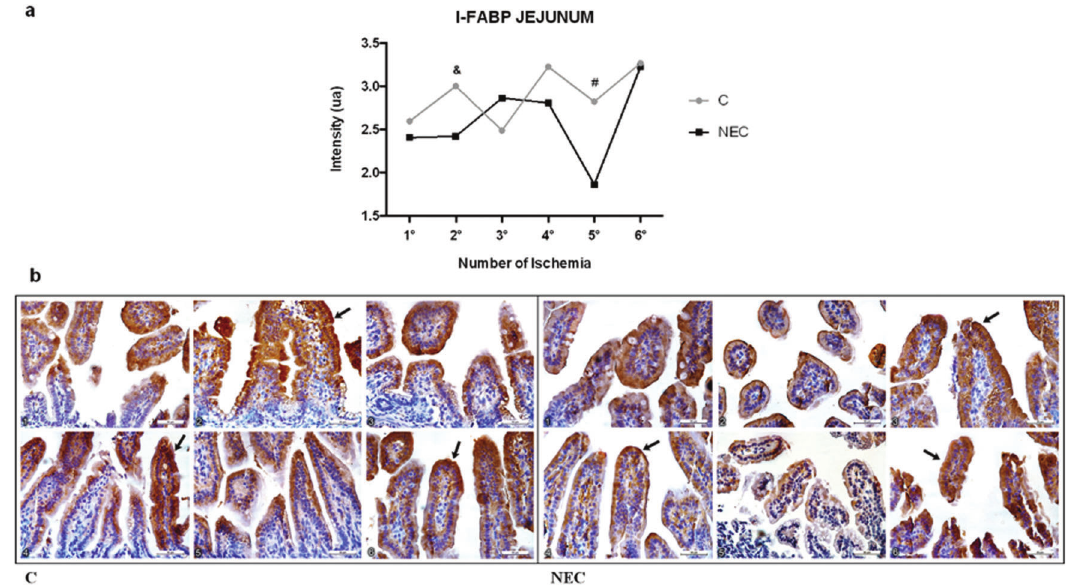
Figure 3 - Graphs of I-FABP expression in the jejunum. a) The means and standard deviation of the arbitrary scores of I-FABP immunolabeling intensity (au) in the jejunum over three days were compared between the two groups. b) Immunohistochemistry for I-FABP in the jejunum relative to the C group. I-FABP immunolabeling intensity increased from the first to the sixth experimental time point (scale bar=50 m m). & p o 0.005; # p o 0.0005.